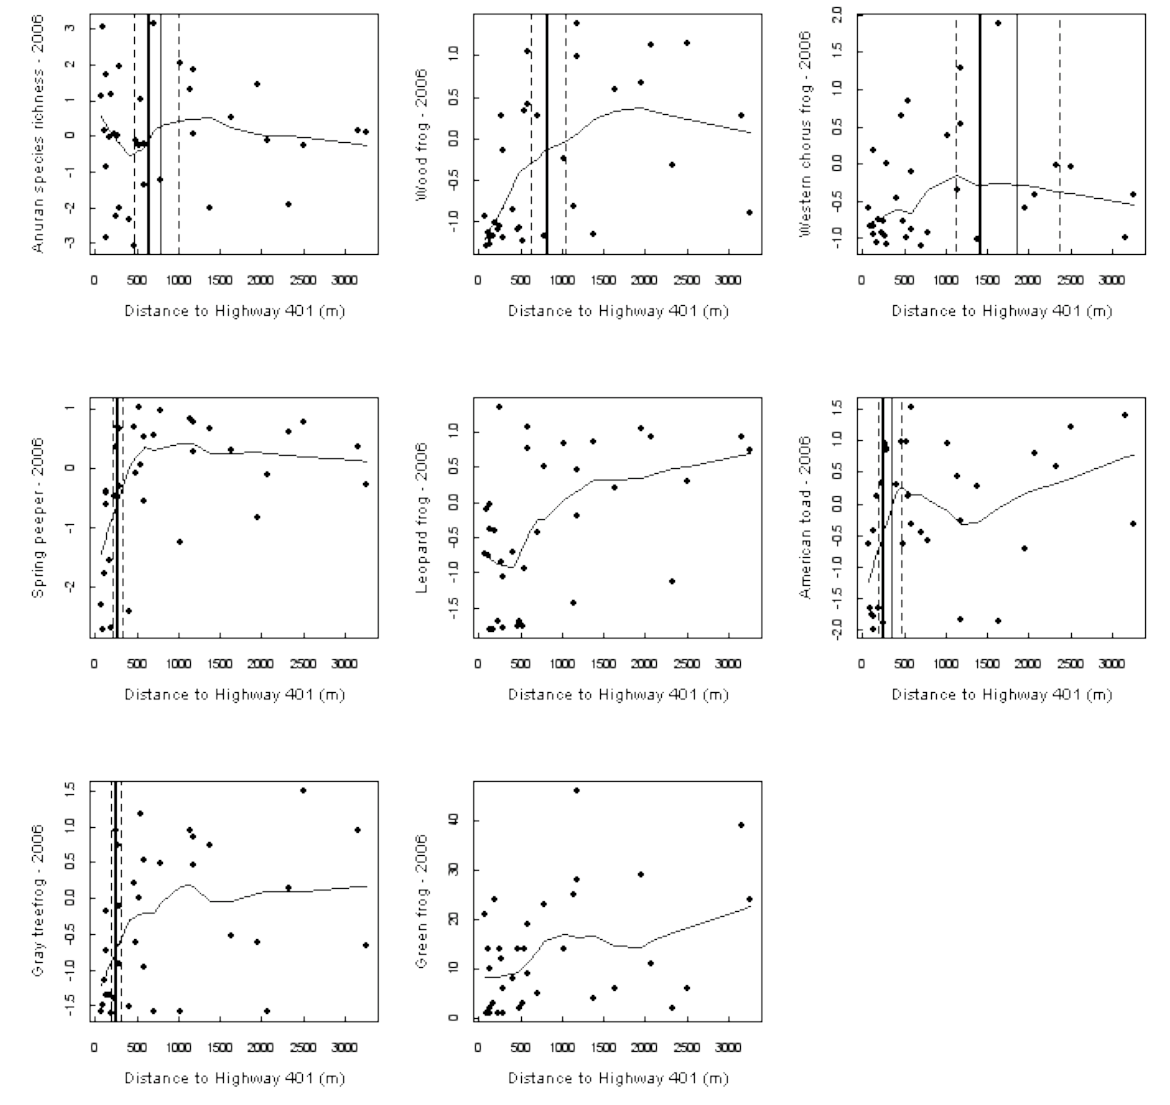
Fig. 3. Relationship between anuran relative abundance, species richness, and distance to Highway 401 (residuals after controlling for significant local predictors; Table 3) in 2006 ( n = 34). The lowess smoothing line is shown. For species fitted with a piecewise regression model, the breakpoint of the best fitting model is shown by heavy solid vertical line; the second best-fitting breakpoint for the American toad, chorus frog, and species richness is shown by the second, but thinner, solid vertical line. One SD below the smallest breakpoint and 1 SD above the largest breakpoint are shown (dashed vertical lines). For the leopard frog and green frog, relative abundance was defined as the maximum number of adults seen during visual surveys. For all other species, relative abundance was defined as the chorus counts summed over all